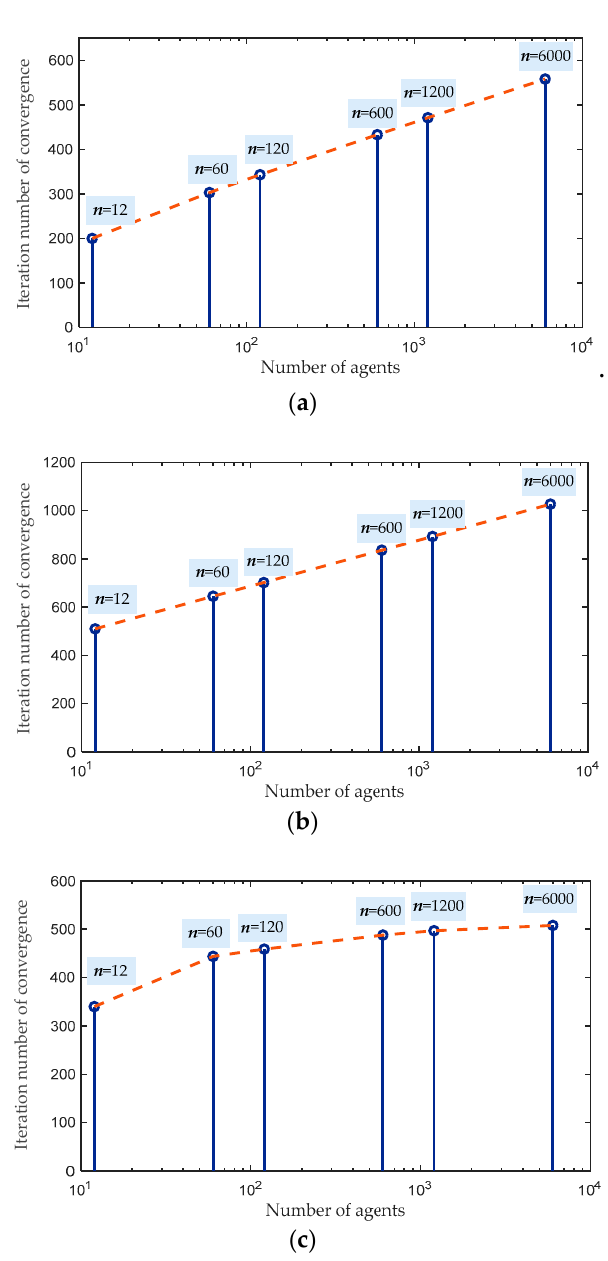
Figure 12. Iteration number of convergence under different numbers of agents by ACA. ( a ) Scenario #1; ( b ) Scenario #2; ( c ) Scenario #3.